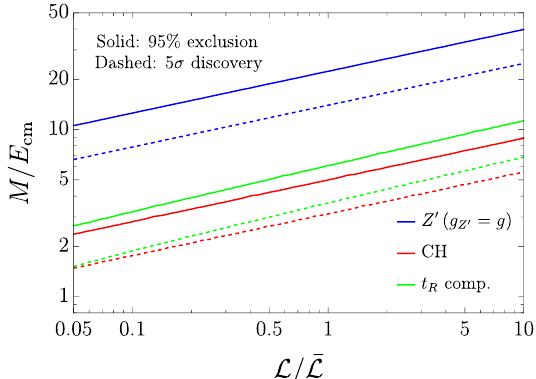
Figure 12. Reach on the new physics scale at 2 σ (continuous) and at 5 σ (dashed), relative to the collider energy, as a function of the integrated luminosity normalized to eq. (3.1). The red lines are for Universal manifestations of Higgs compositeness, while the green ones include the effect of Top compositeness in the (cid:15) = 1 , (cid:15) = y scenario. The blue lines are for the Y -universal Z 0 for a t q t /g ∗ fixed coupling g = g Z 0